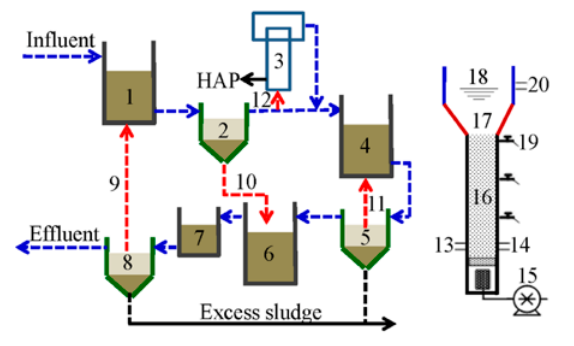
Fig. 1. Schematic diagram of the BNR-IC process.1– anaerobic tank; 2– settling tank; 3– IC column; 4– nitrification tank; 5– settling tank; 6– anoxic tank; 7– post-aeration tank; 8– settling tank; 9– sludge return; 10– sludge bypass return; 11– sludge return; 12– later flow; 13– influent of P-rich solution; 14– feeding CaCl2 solution; 15– aeration; 16– IC reaction zone; 17– buffer zone; 18– settling zone; 19– sample point;